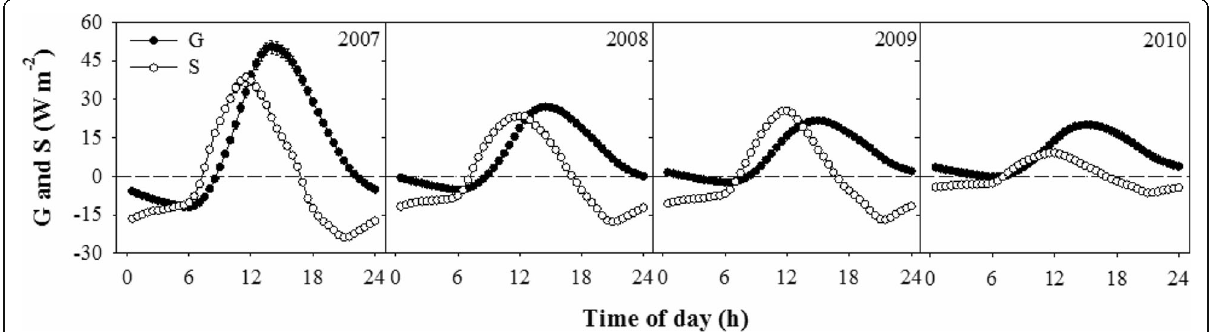
Fig. 10 Diurnal change of half-hourly soil heat flux ( G ) (closed circle) and soil heat storage ( S ) (open circle) during the growing seasons of 2007 –